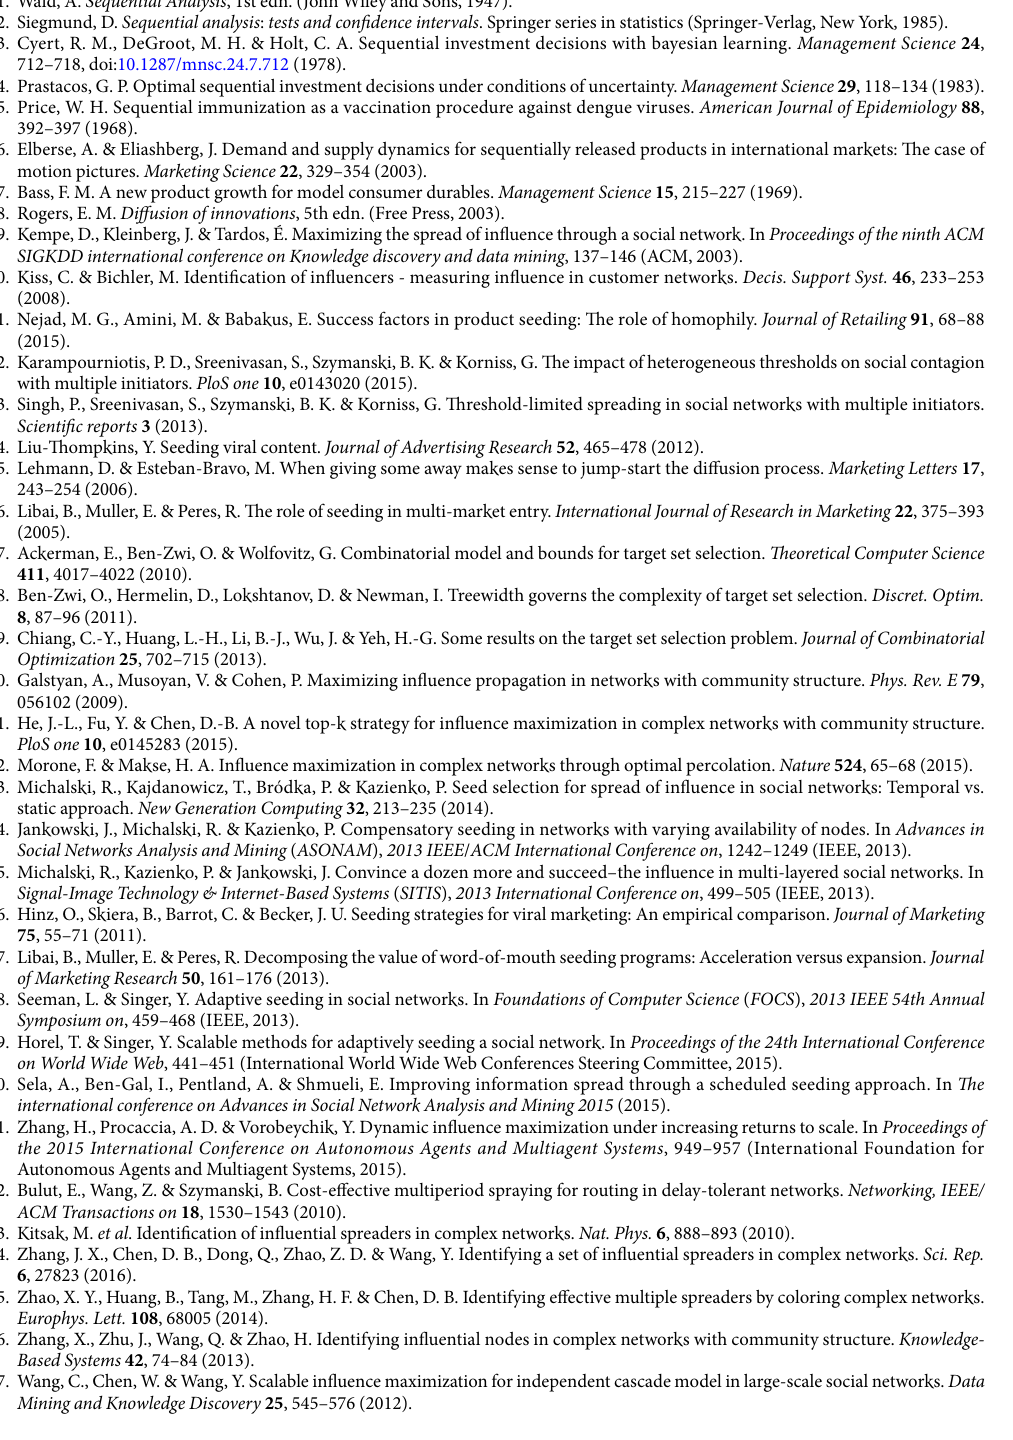
Figure 5 and Table 3 provide details on performance of the introduced sequential seeding strategies in terms of trade-off values. The greatest coverage can be achieved by means of longer sequences resulting in longer execu- tion. If the process is limited in time that is very short, the sequential strategies may be less justified. Here we showed both experimentally and theoretically that the average coverage of any strategy of ranking nodes for selection of all seeds at the beginning of the process can be improved with sequential seeding using the same ranking. This is because the proposed method is dynamic as it adapts the set of activated seeds to the pro- gress of the execution of diffusion active between stages of